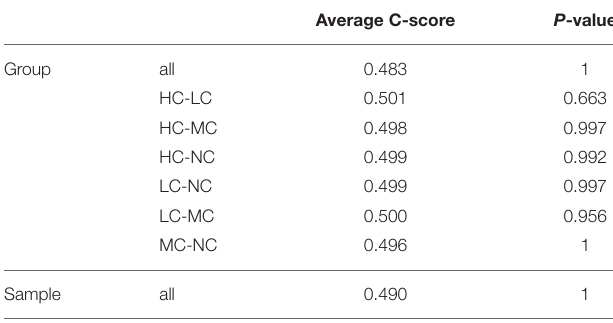
TABLE 3 | Co-occurrence analysis by calculating